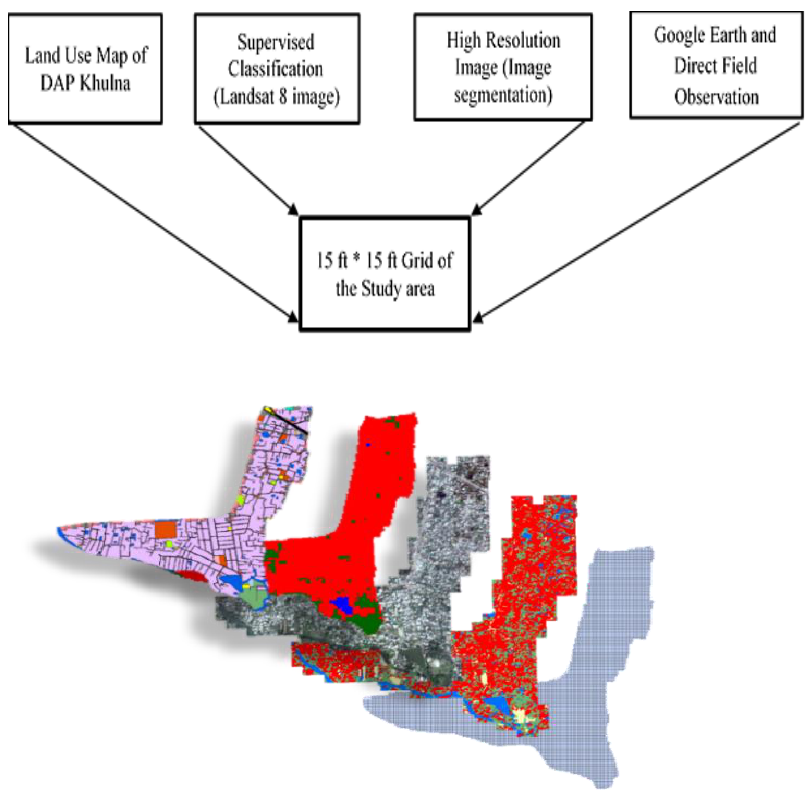
Figure 3. Knowledge-based Image Classification Process Flow.